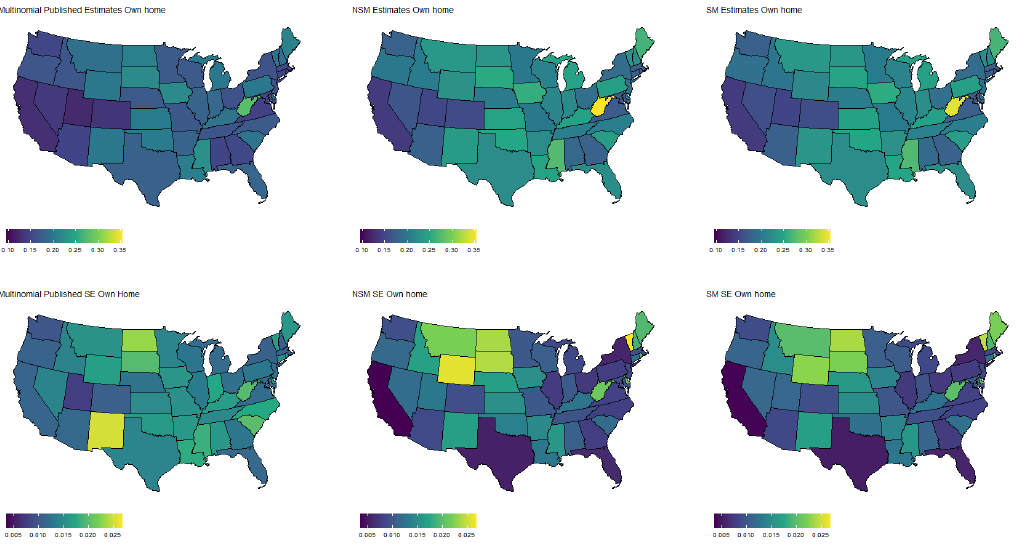
Figure 4. Estimated population proportion of people who have a home mortgage by state (excluding Alaska and Hawaii) and D.C. for each estimator along with corresponding standard error in Week 1 of the Household Pulse Survey. Estimates are plotted on the same color scale, and SEs are plotted on another color